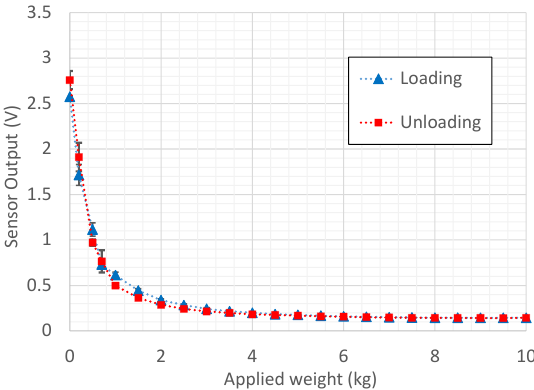
Figure 22. Experiment results: sensor output voltage vs. applied weight plot obtained using dead-weight testing with error bars based on standard deviation.